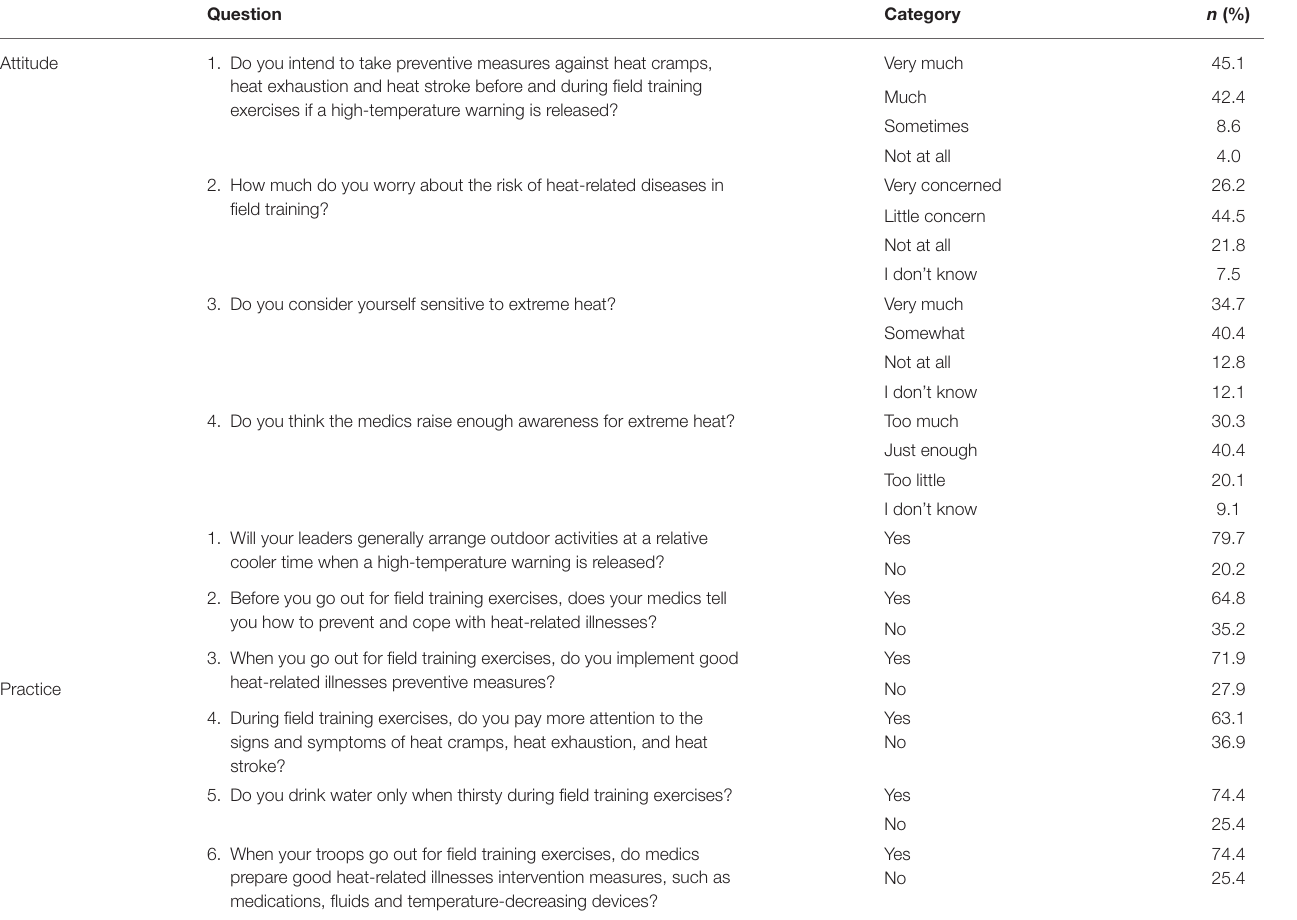
TABLE 3 | Responses to attitude and practice items ( n =